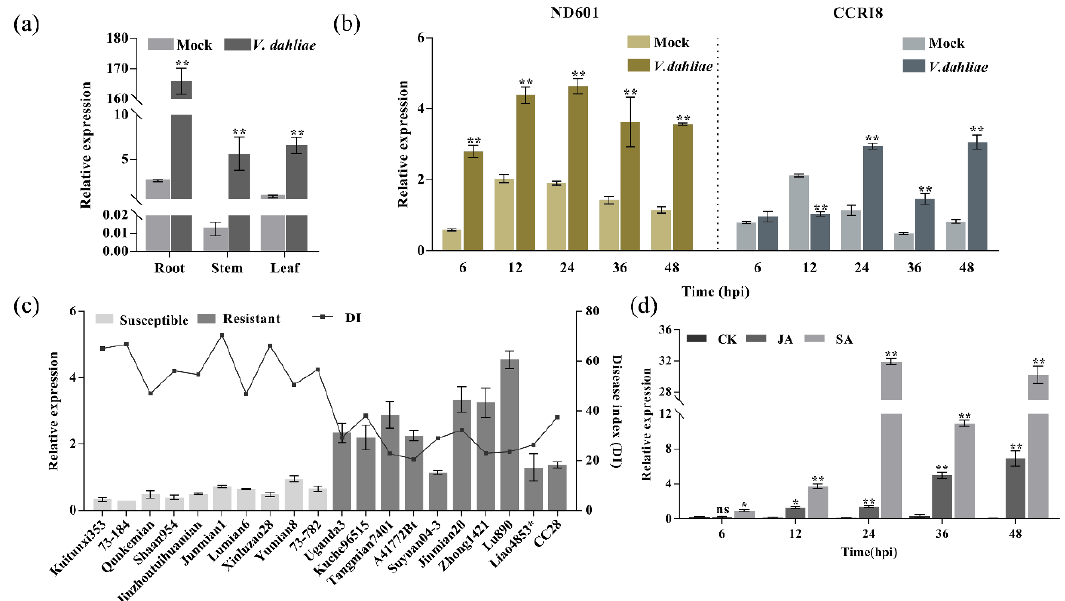
Figure 4. Expression analysis of GhENODL6. ( a ) Expression analysis of GhENODL6 in different organs of cotton plant under Verticillium wilt stress. ( b ) Expression analysis of GhENODL6 in ND601 and CCRI8 roots under VW stress. ( c ) Expression of GhENODL6 in ten resistant and ten susceptible upland cotton cultivars upon infection with V. dahliae . ( d ) Expression analysis of GhENODL6 with the treatment of water, JA, and SA, respectively. All experiments were repeated at least three times. Values are means with standard deviation (SD) ( n = 3 biological replicates). Error bars represent the SD of three biological replicates. Asterisks indicate statistically significant differences according to Student’s t -test (two-tailed) (*, p < 0.05 **, p < 0.01). All experiments were repeated at least three times. Vd, V. dahliae ; CK, control; ns, not significant.